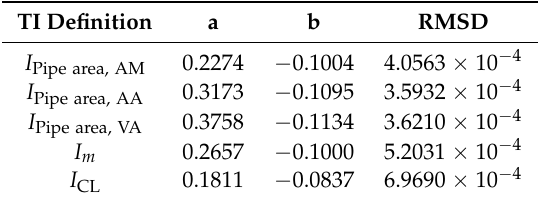
Table 1. Power-law fit constants, smooth pipe.